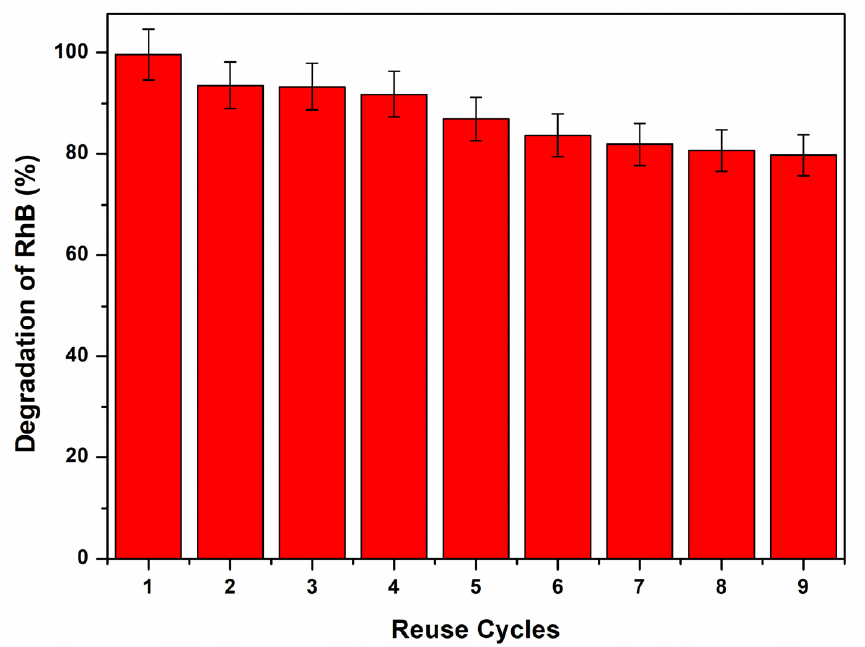
Figure 11. Effect of reuse cycles of the BVO@C electrode in the PEC system on the removal of RhB in 30 min.